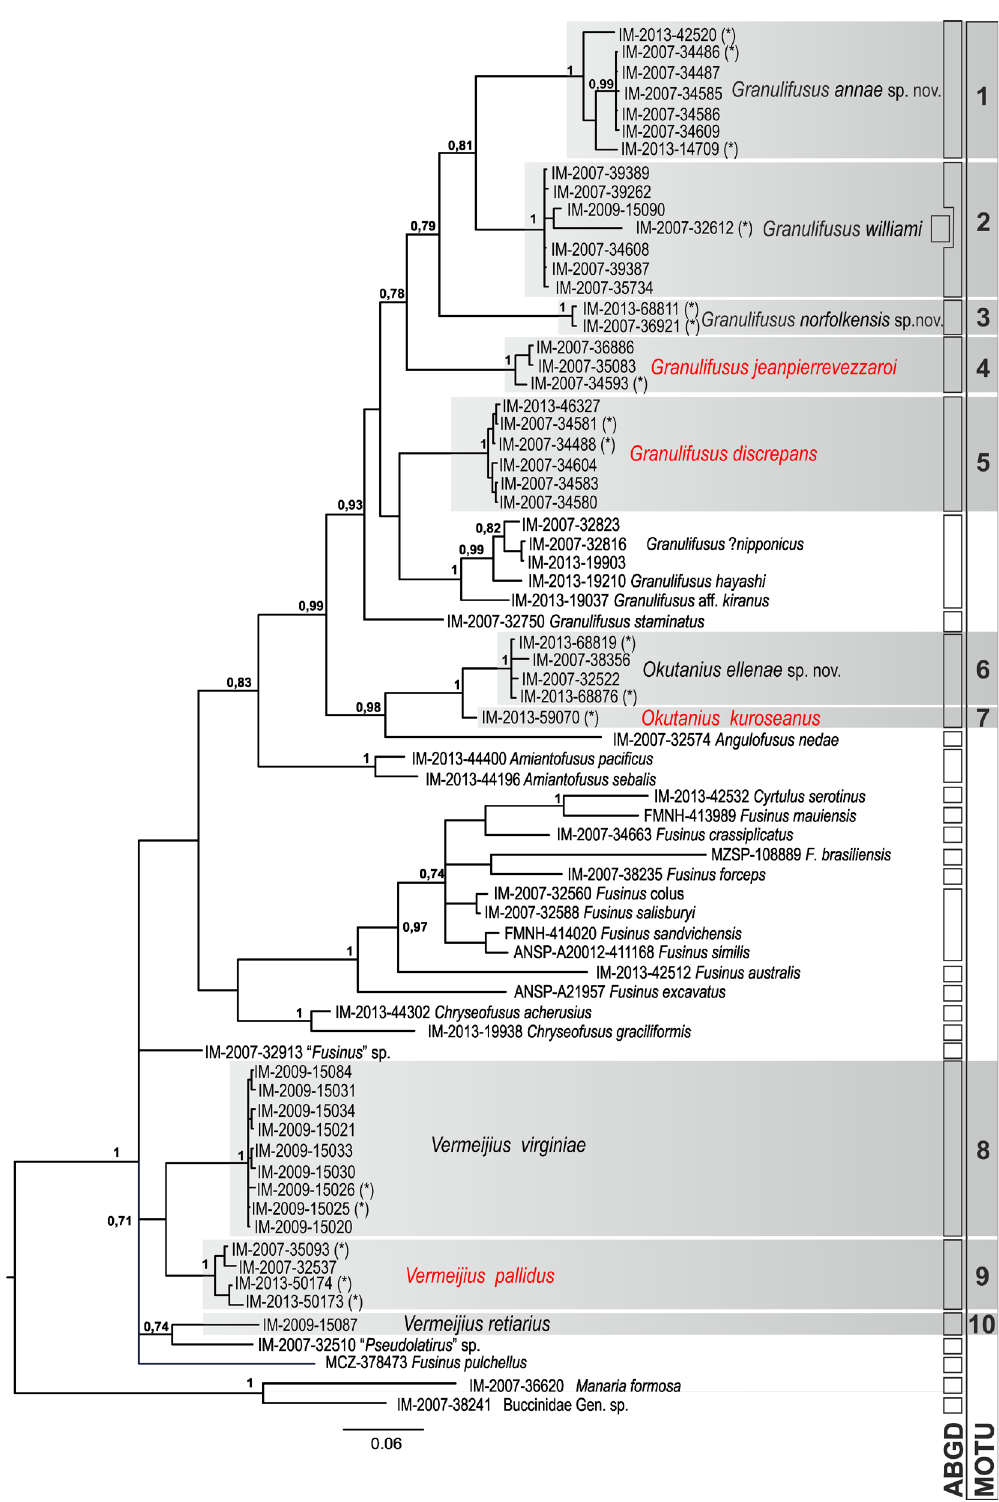
Fig. 1. Bayesian phylogenetic tree of the subfamily Fusininae based on the COI gene. Support values as Bayesian posterior probabilities (PP) indicated when > 0.7. Asterisks mark specimens illustrated on figures. The names of the species previously attributed to Pseudolatirus are given in orange. Partitions recovered by ABGD marked as vertical line of rectangles on the right. MOTUs identified in the current study are highlighted in